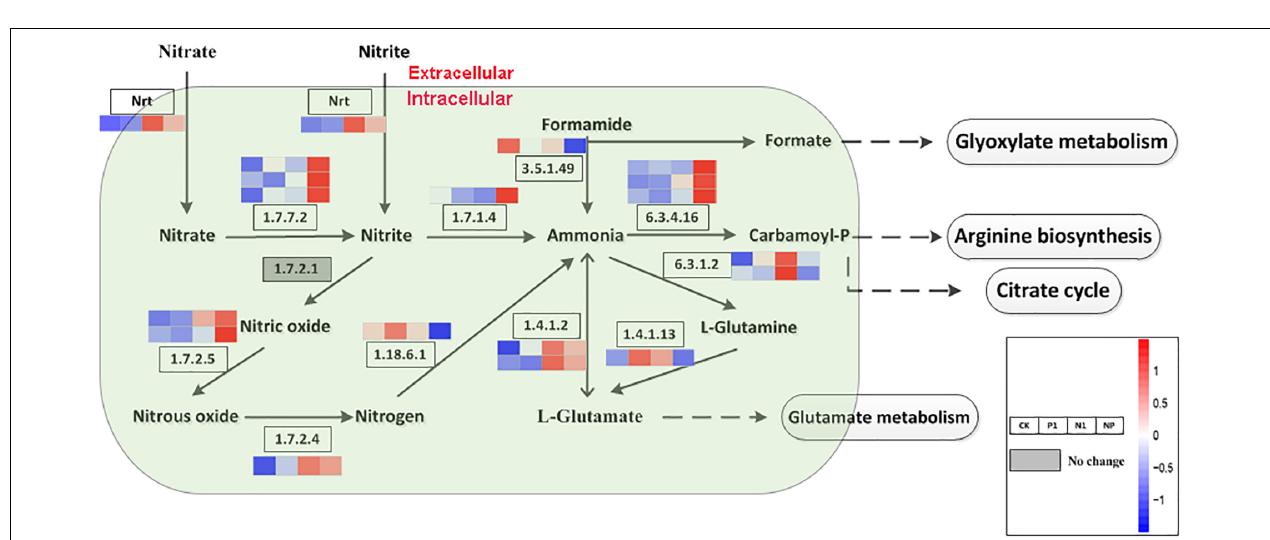
FIGURE 2 | Distribution of differentially expressed genes (DEGs) in the six samples. (A) DEG distribution between control and nitrogen and phosphorus limitation. (B) Venn diagram exhibiting DEG distribution in three samples. CK, the control; P1, the single P limitation (P-); N1, the single N limitation (N-); NP, N deep limitation and P limitation (N-